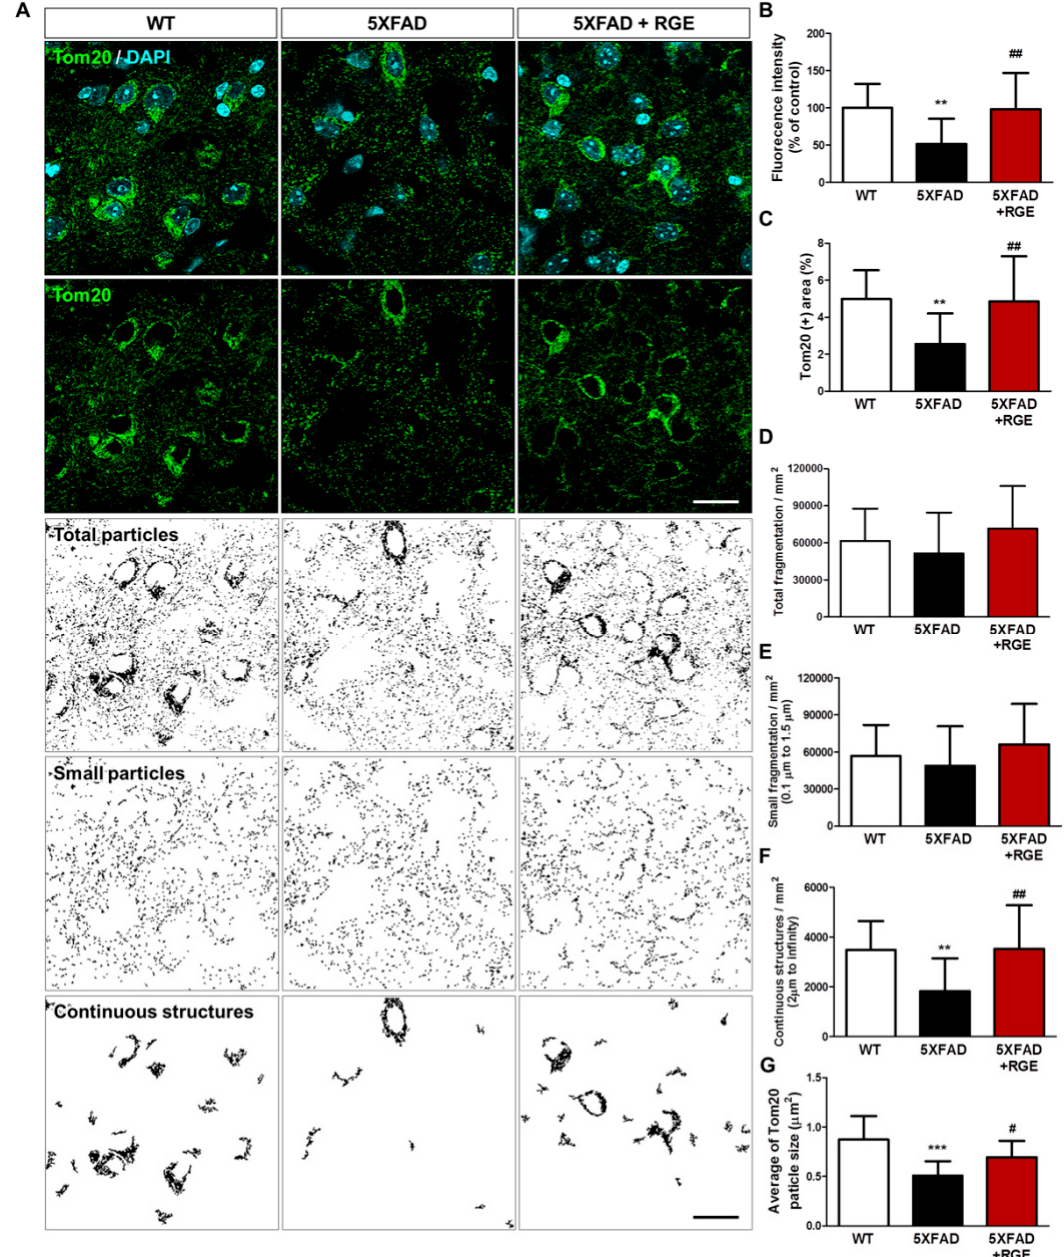
Figure 2. Effects of RGE on changes in mitochondrial dynamics caused by A β accumulation in the subiculum of 5XFAD mice. ( A ) Immunohistochemical staining for translocases of mitochondrial outer membrane 20 (Tom20) was performed to evaluate the mitochondrial dynamics (scale bar = 20 µ m). ( B ) The quantification results of Tom20 fluorescence intensity were normalized to the values for vehicle-treated wild-type (WT) mice. ( C ) Tom20 ( + ) area was quantified and plotted as a percentage. Total fragmentation ( D ), small fragmentation ( E ), continuous structures ( F ), and average Tom20 particle size ( G ) were quantified by setting the immunoreactivity area of Tom20 to a threshold by mitochondrial structure size to identify the fusion and fission of mitochondria. Data are presented as mean ± SEM. ** p < 0.01 and *** p < 0.001: vehicle-treated WT mice (white bar) versus vehicle-treated 5XFAD mice (black bar). # p < 0.05 and ## p < 0.01: vehicle-treated 5XFAD mice versus A β + RGE-treated 5XFAD mice (red bar).